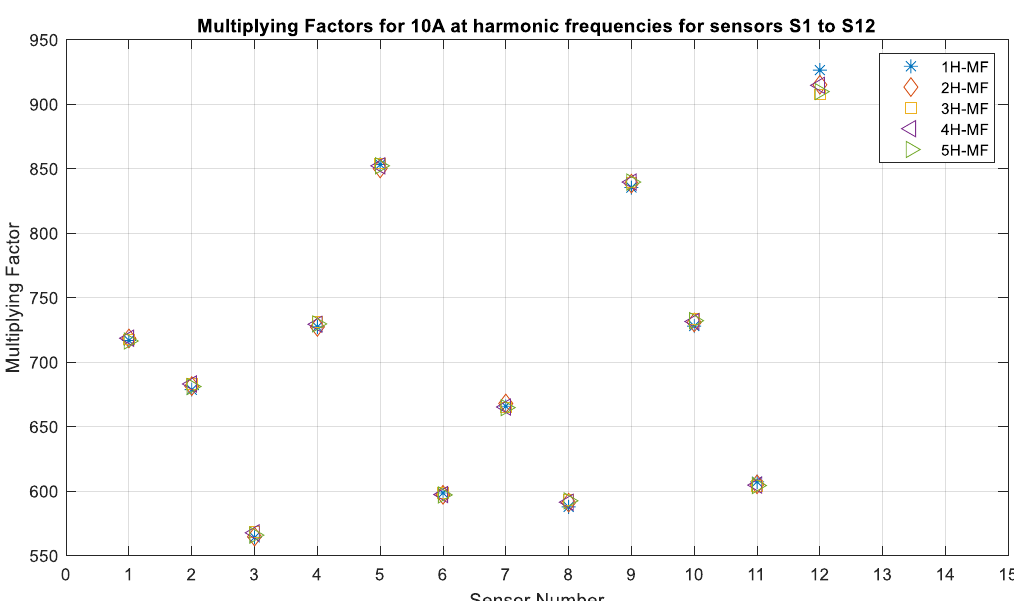
Figure 18. Multiplying factors of all sensors for 10 A, 7 mm, 60 Hz and its harmonics: WI and NI cases.